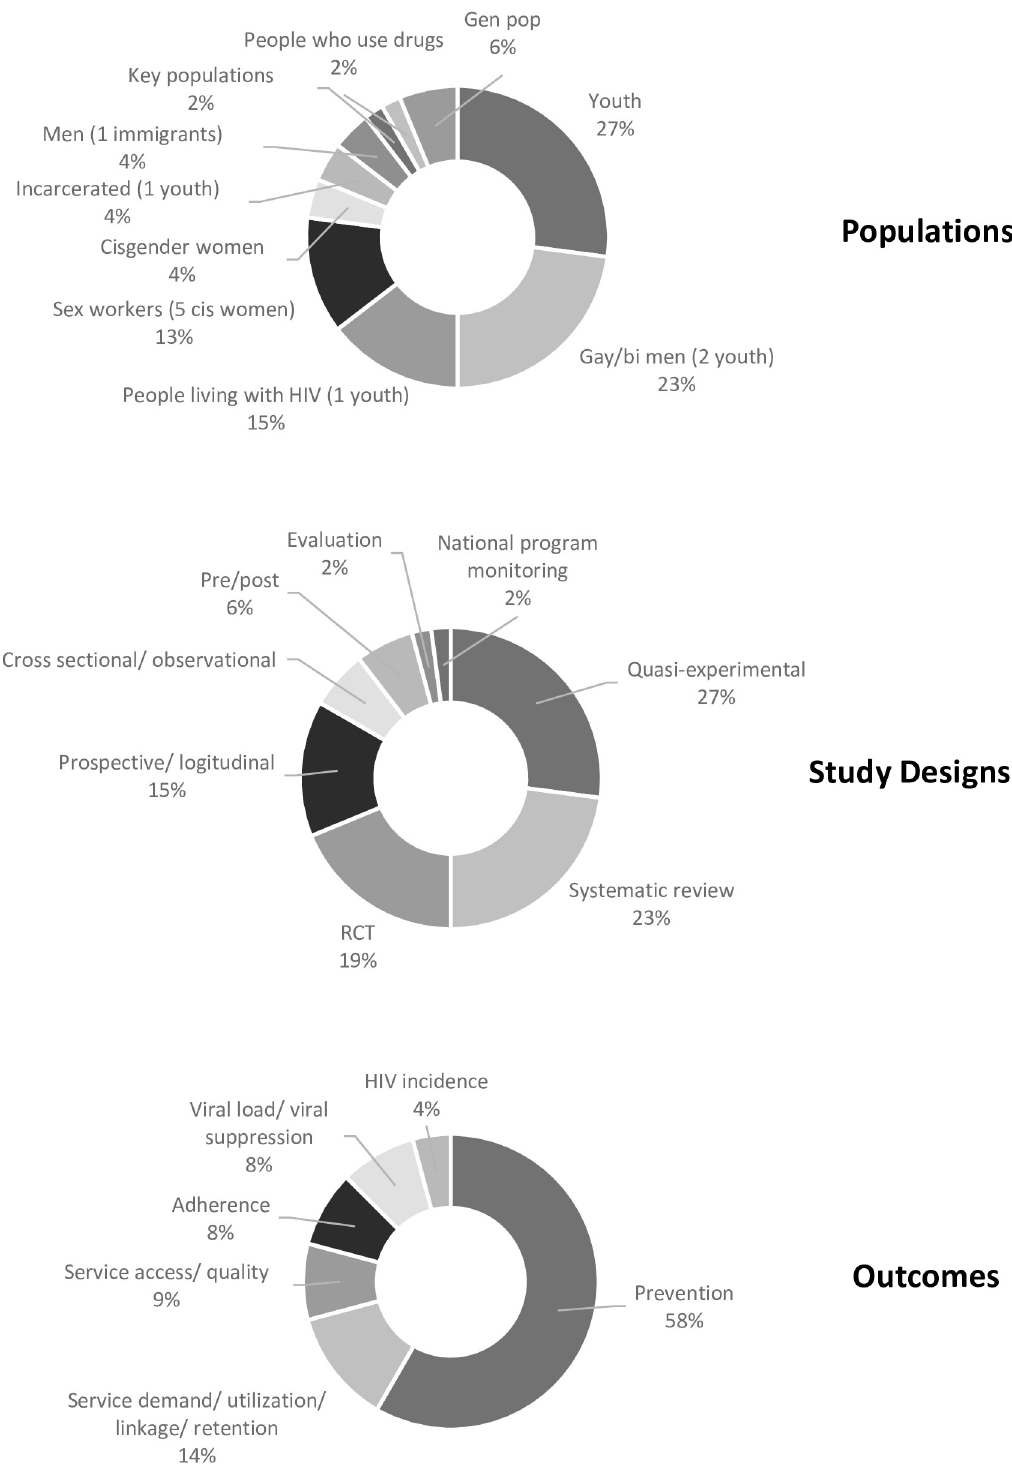
Fig 2. Study characteristics of research included in the scoping